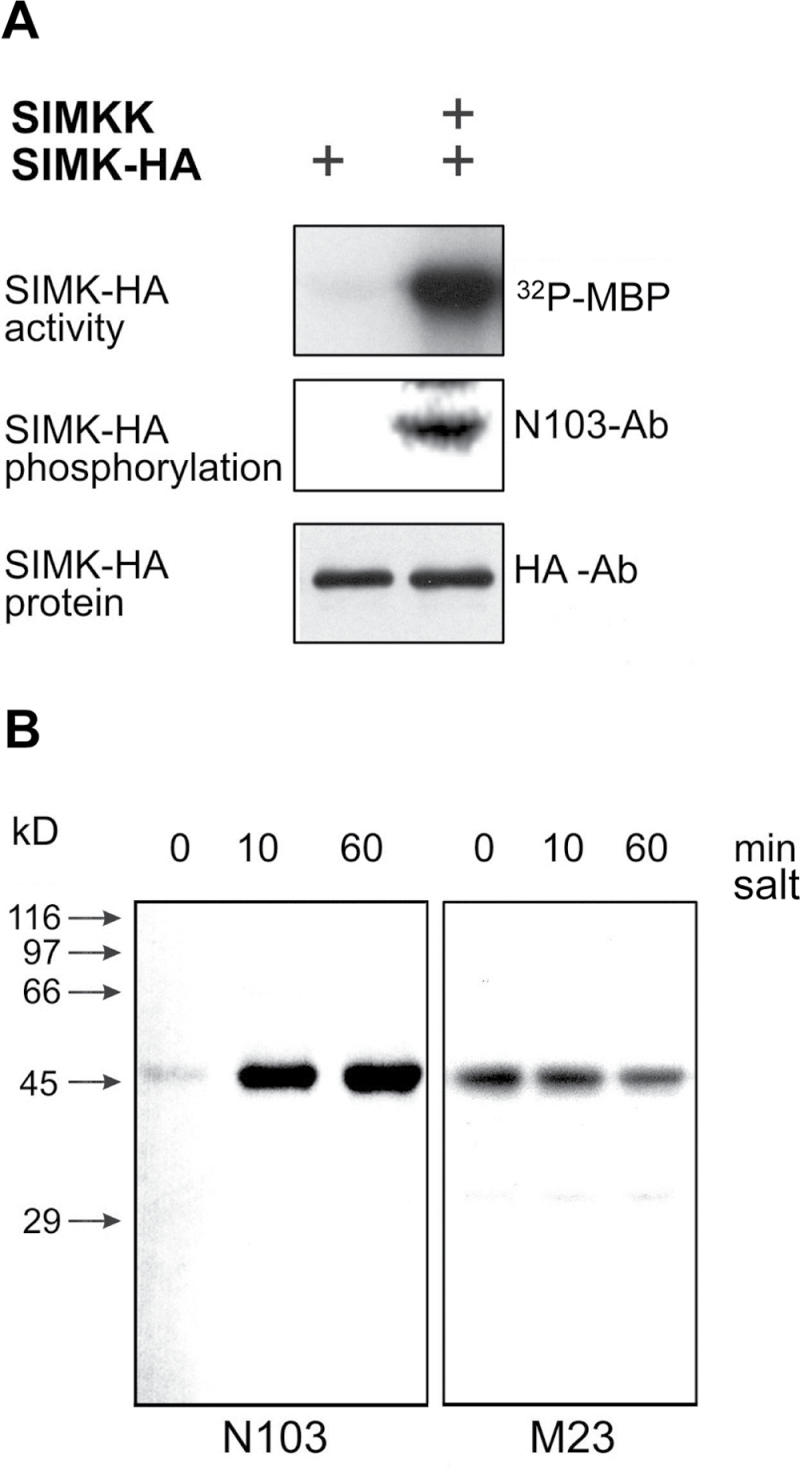
Immunokinase assays and immunoblotting with the phospho-specific and protein-specific SIMK antibodies. (A) Immunokinase assays (upper panel) and immunoblotting with phospho-specific N103 (middle panel) and HA (lower panel) antibodies in Arabidopsis protoplasts co-transformed with HA-tagged SIMK and its upstream activator SIMKK. Note that the N103 antibody recognizes SIMK activated by its upstream activator SIMKK. (B) Immunoblotting with the phospho-specific N103 and protein-specific SIMK antibodies in control and salt-treated M. sativa roots. Roots were treated with 250mM NaCl for the indicated times and crude extracts from roots were subjected to immunoblotting using N103 and M23. In control untreated roots (0min), extremely weak labelling with N103 was obtained whereas after 10 and 60min treatment with salt, N103 recognized a 46kDa band corresponding to SIMK, as revealed by the M23 antibody in the same experiment. Note that labelling with N103 got slightly stronger with increased time of root exposure to the salt stress.